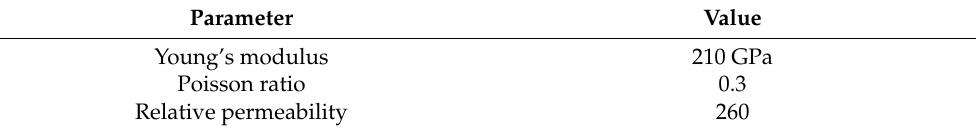
Figure 1. Experiment setup. ( a ) The inspection setup block diagram; ( b ) experimental equipment. Table 1. Properties of the SA 106 specimen. Table 1. Properties of the SA 106 specimen.